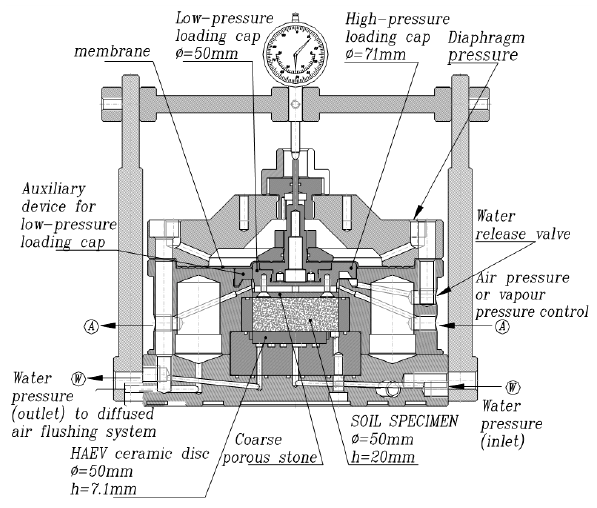
Figure 3. Cross-sectional structure of the oedometer cell.